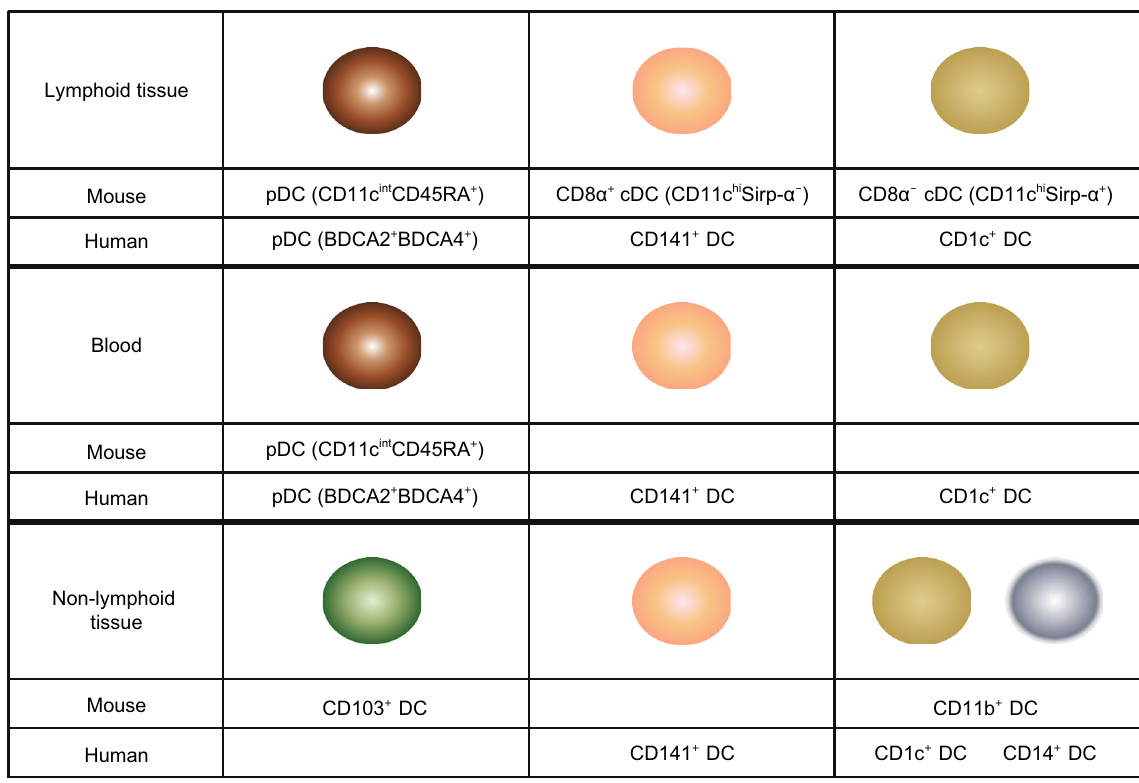
Figure 1. DC subsets in the lymphoid and non-lymphoid tissues of mouse and human. Lymphoid tissues in mouse contain pDC, CD8 α + cDC and CD4 + cDC, while lymphoid tissues in human contain pDC, CD141 + DC and CD1c + DC. Mouse peripheral blood contains pDC while human blood contains pDC, CD141 + DC and CD1c + DC. Non-lymphoid tissues in mouse contain CD103 + DC and CD11b + DC, while non-lymphoid tissues in human contain CD141 + DC, CD1c + DC and CD14